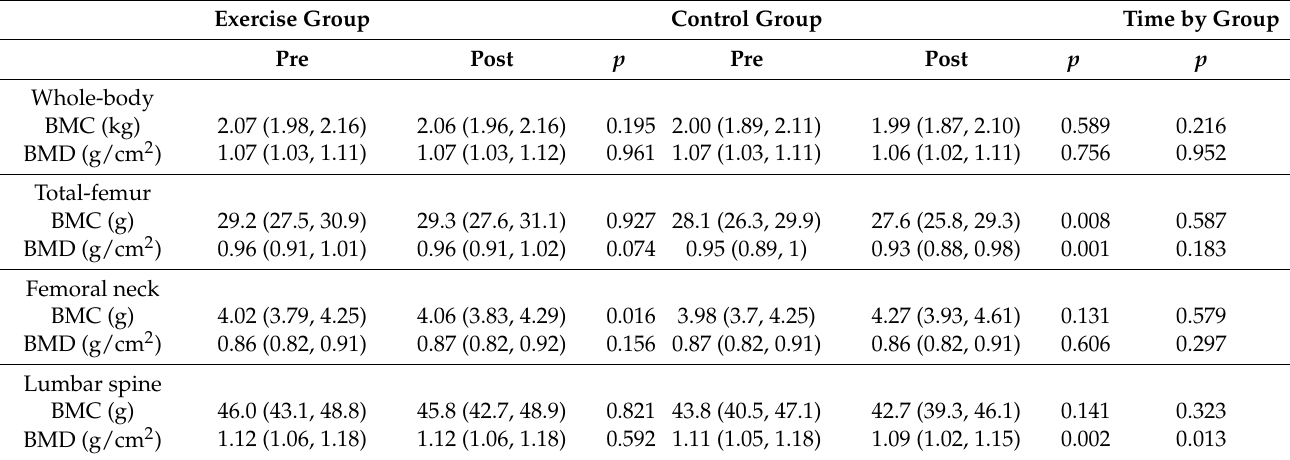
Table 2. Pre- and post-intervention values of bone properties for the exercise and control groups.